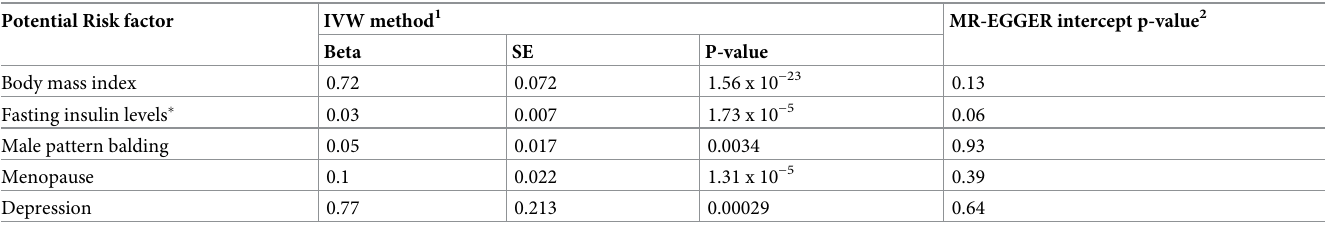
Table 5. Mendelian randomization using an inverse weighted variant